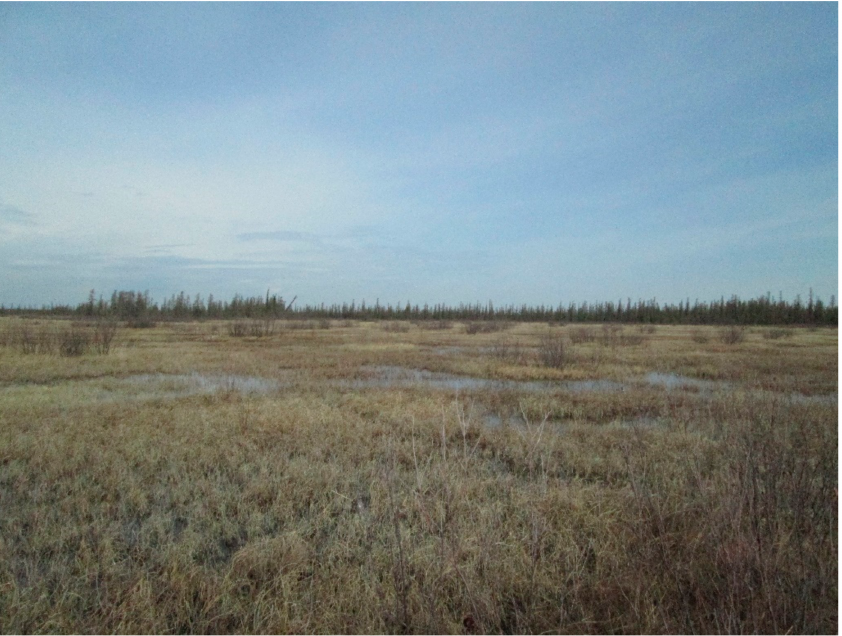
Figure 7. Field site picture capture in May 2014. This site is frequently occupied by YERA and had one of the highest predicted occupancy